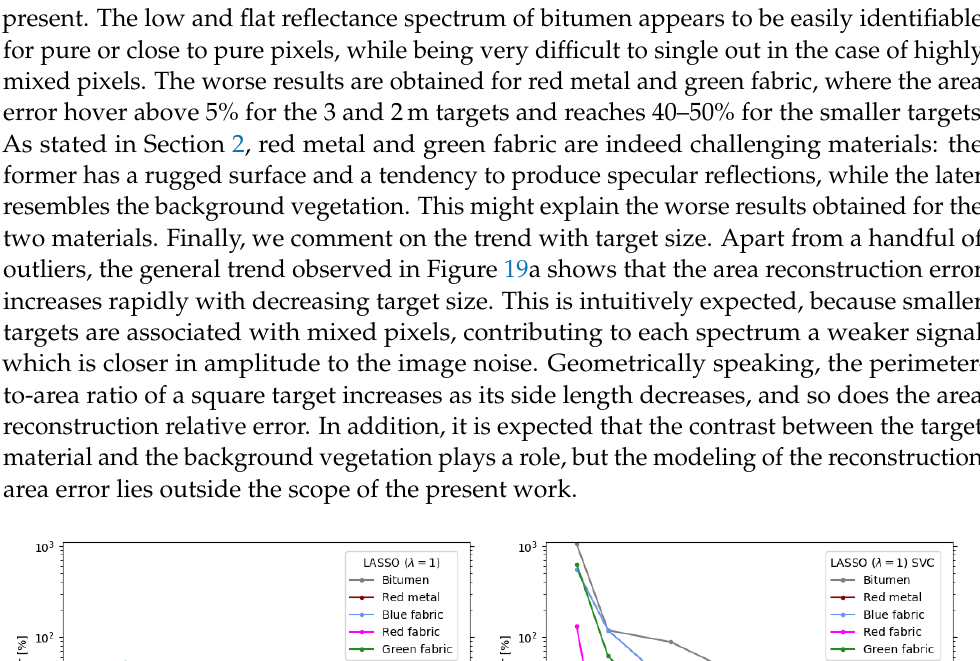
ˆ A t − A t | / A t . The results are shown for the |